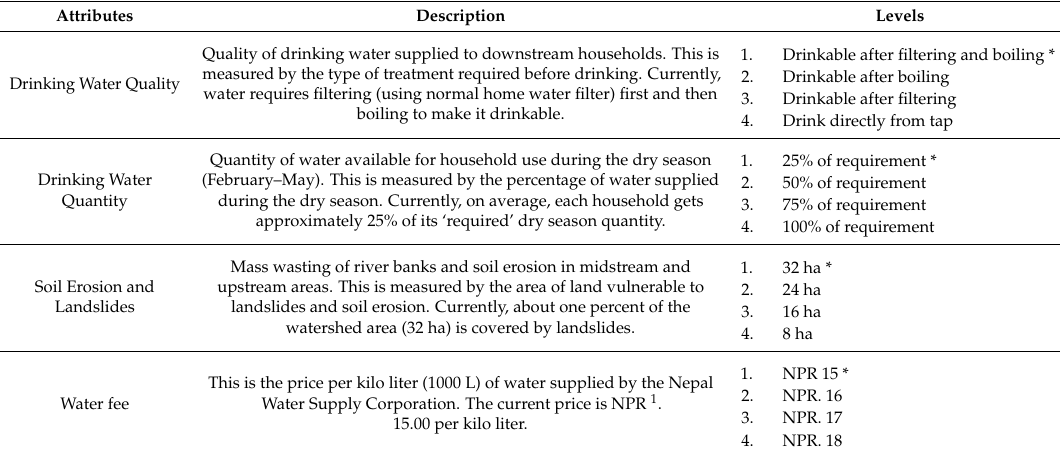
Table 1. Selected attributes of watershed management and their levels identified for assessing downstream (Dharan municipality) demand for